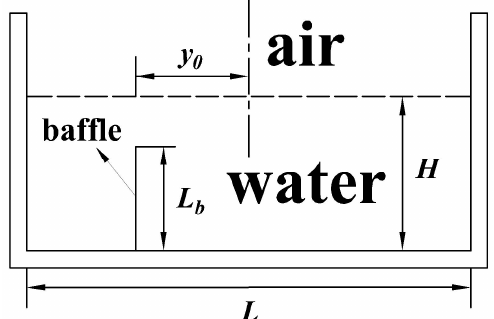
Figure 4. Rectangular vessel with vertical baffle inside.